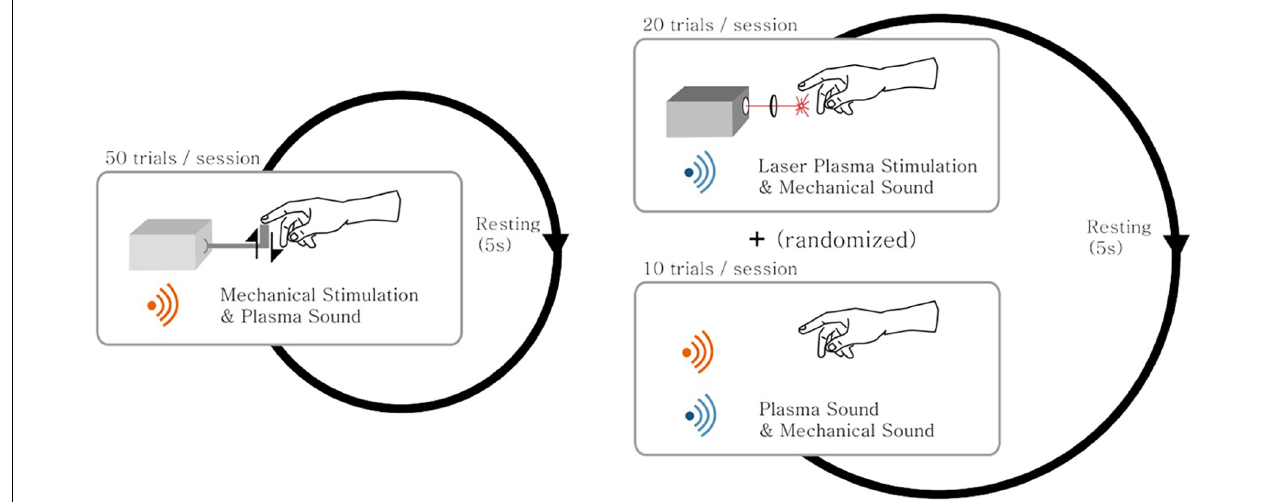
FIGURE 2 | A schematic diagram of the experimental design. The experiment consisted of both the mechanical stimulation session and the laser plasma stimulation session mixed with sham stimulation. (Left) In the mechanical stimulation session, a total of 50 trials of mechanical stimulation along with the auditory laser plasma sound were given to the subjects. (Right) In the laser plasma stimulation session, a total of 20 trials of laser plasma stimulation along with the mechanical stimulation sound were given to the subjects. In addition, a total of 10 trials of sham stimulation with a mixed sound of both laser plasma and mechanical sounds interspersed with the laser stimulation trials in a random fashion. The subjects rested for 5 s between successive trials of